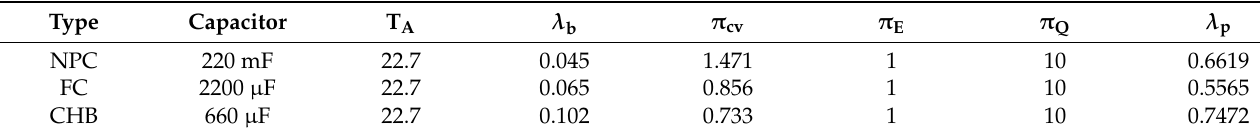
Table 8. The Estimated typical capacitor failure rate.